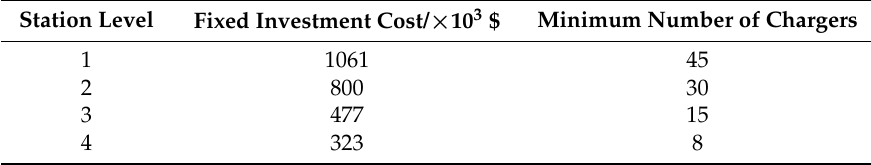
Table 3. The fixed investment cost with different levels.